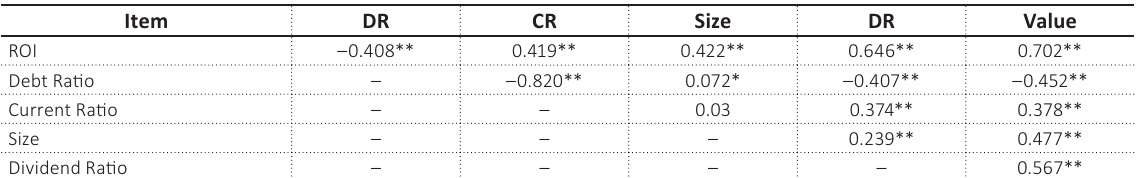
Table 3. Spearman correlation